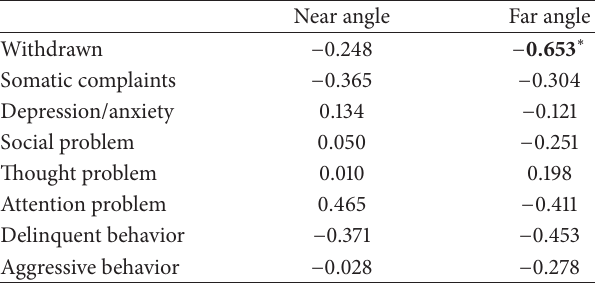
Table 2: Correlation between angle of esodeviation and K-CBCL. Near angle Far